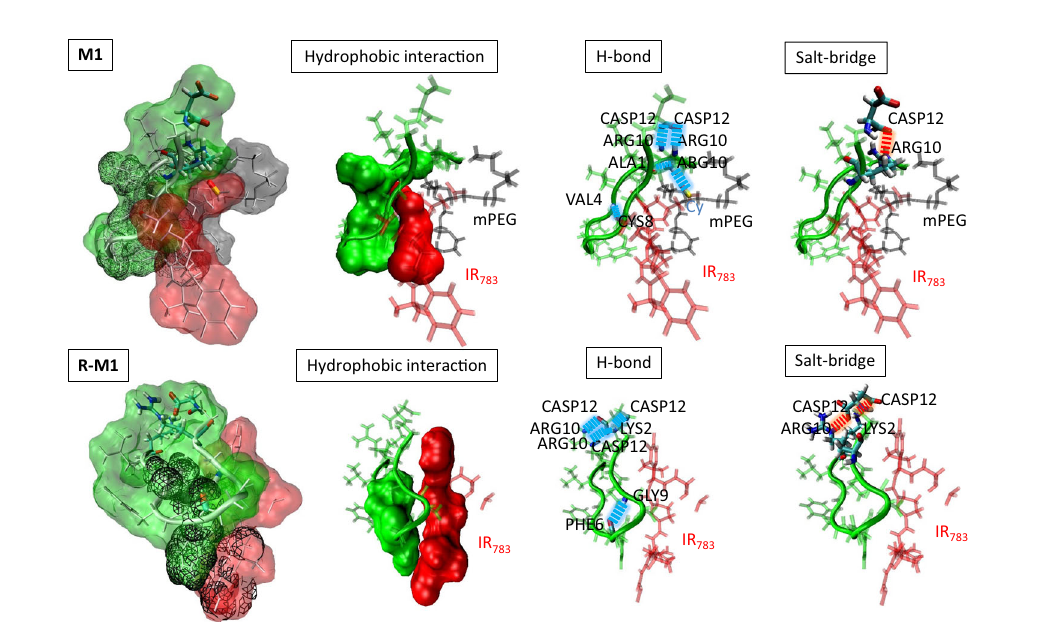
Fig. 2 The molecular dynamics (MD) simulation of M1 and R-M1. The molecular interaction details including hydrogen bond (blue dotted-line), salt-bridge (red dotted-line) and hydrophobic interaction. Red part: IR 783 ; Gray part: mPEG 2000 ; Green part: